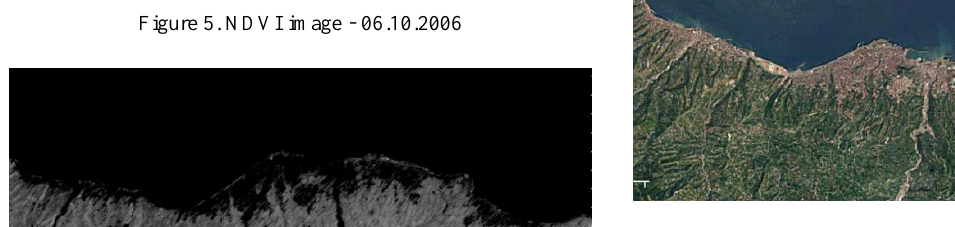
Figure 9. Google Timelapse Image of Trabzon